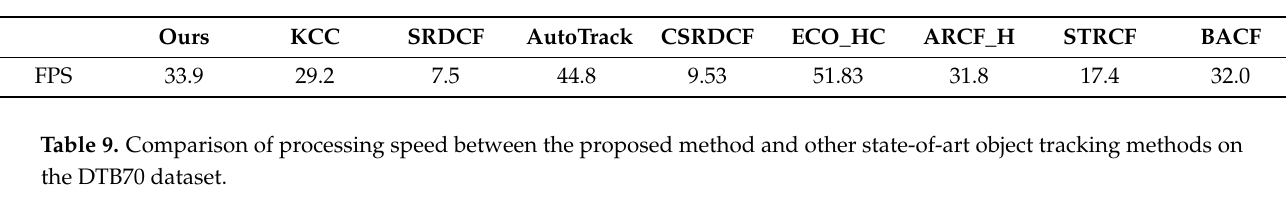
Table 8. Comparison of processing speed between the proposed method and other state-of-art object tracking methods on the UAV20L dataset.